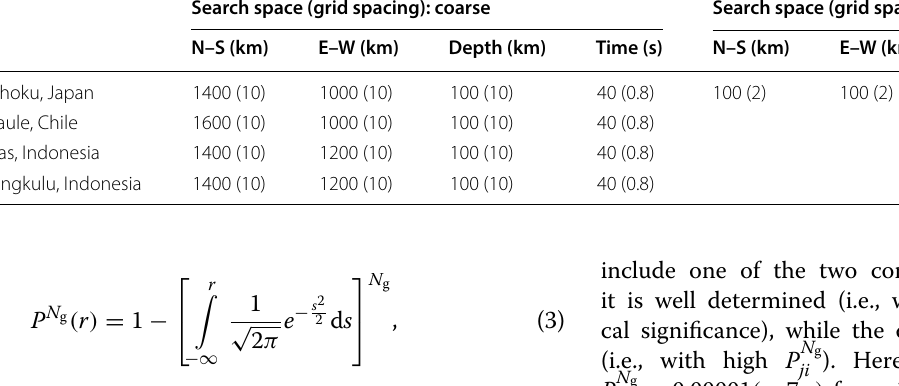
Table 1 Grid-search parameters to determine the relative locations between events Search space (grid spacing): coarse Search space (grid spacing):